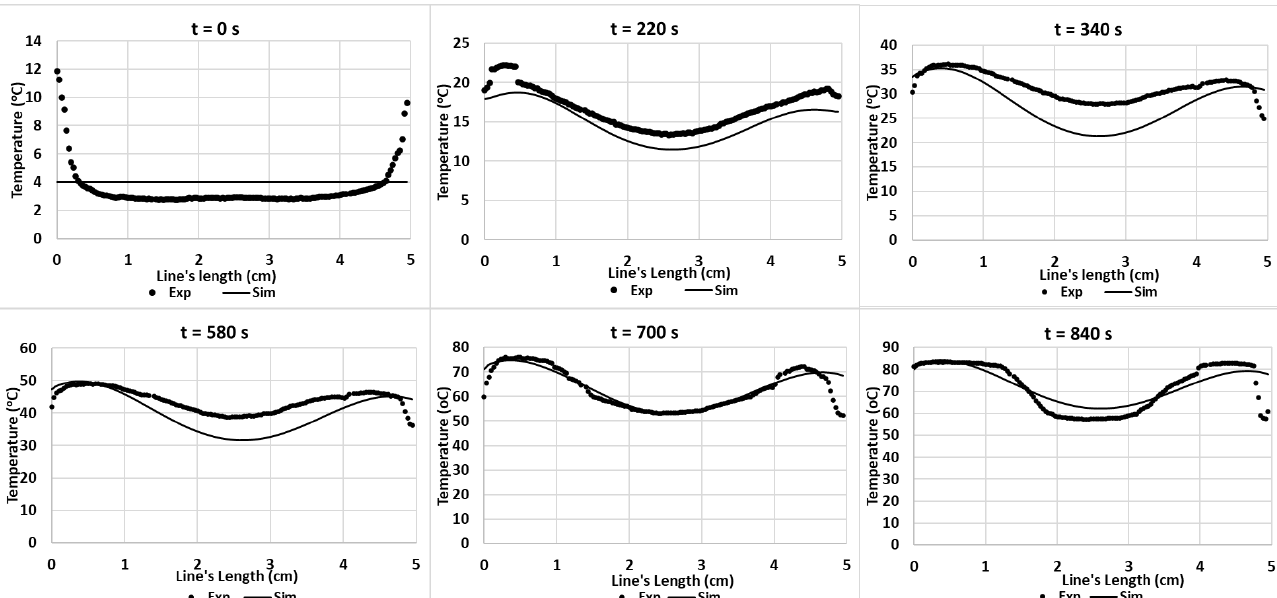
Figure 13. Surface temperature cartography of pâté during the ramp-up heating period at position A (simulation with hc 2 value). (The blue line is the temperature sampling line used in Figure 14).